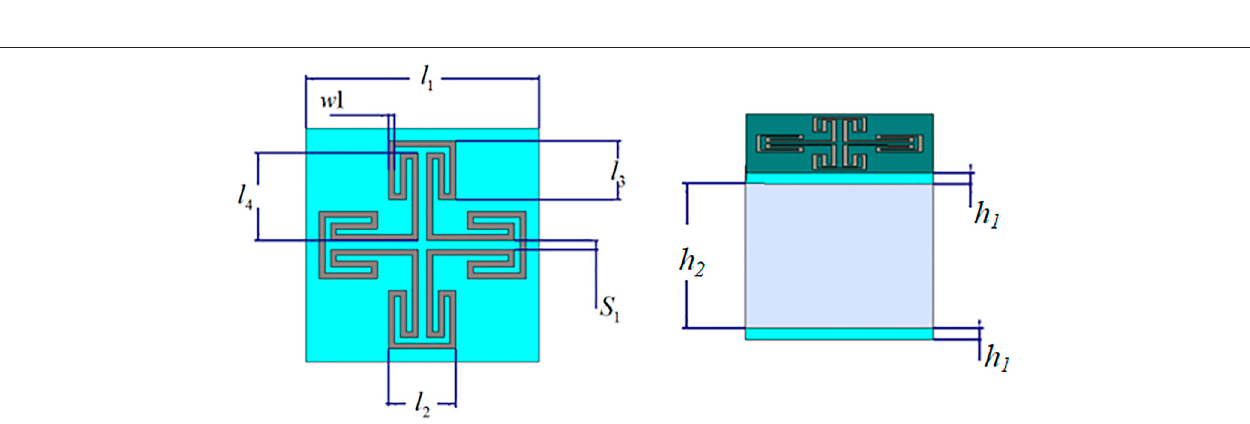
FIGURE 3 | Structure of the lossy FSS.